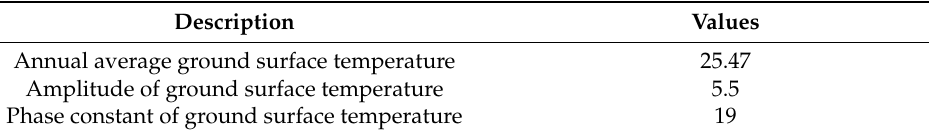
Table 2. Ground temperatures in